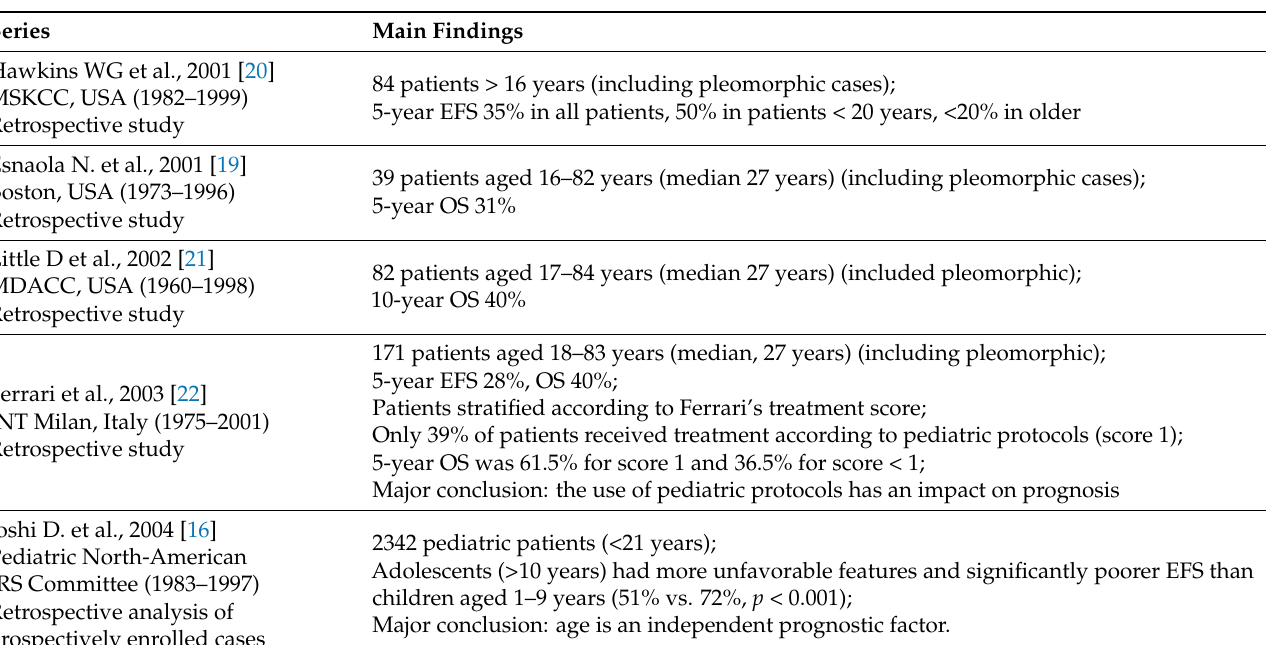
Table 2. Selected studies focusing on adolescent and/or adult patients with